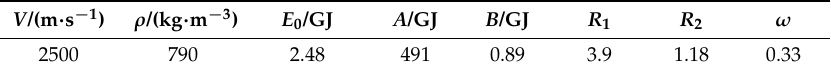
Table 2. EOS (equation of state) parameters of the ANFO explosive